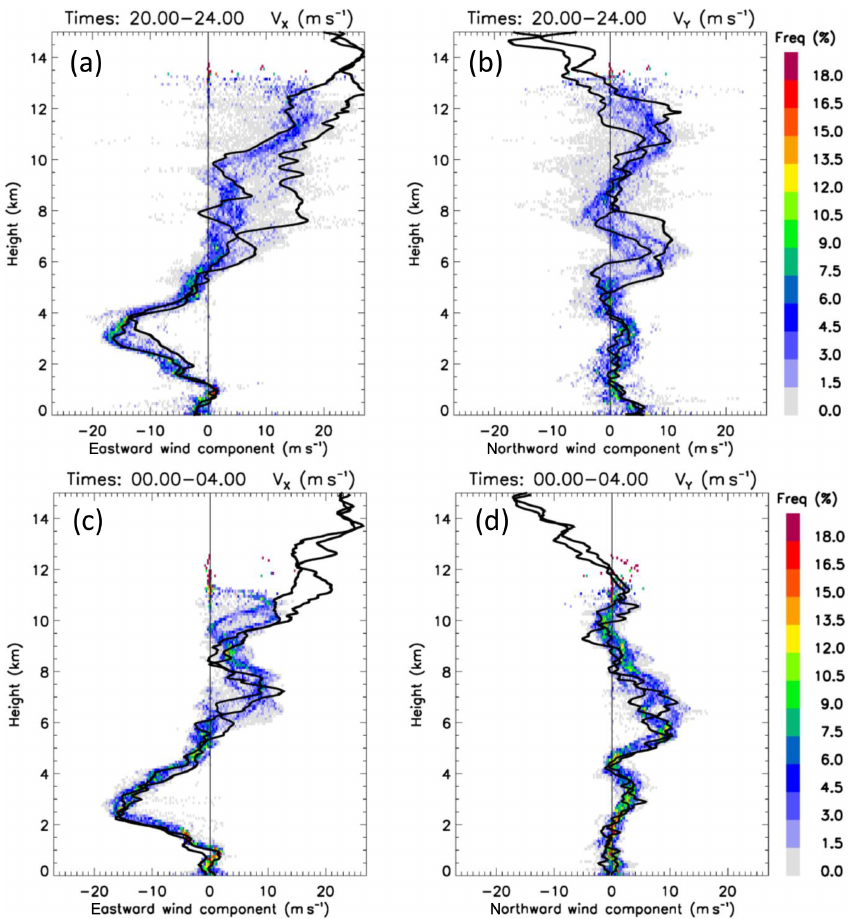
Figure 3. Comparison of (a, c) V X and (b, d) V Y joint wind–height frequency distributions (colours) and the same horizontal wind com- ponents measured by soundings for two time periods: (a, b) 20:00–24:00UTC on 23 November 2019 with sounding launches at 20:15 and 23:15UTC and (c, d) 00:00–04:00UTC on 24 November 2019 with sounding launches at 01:15 and